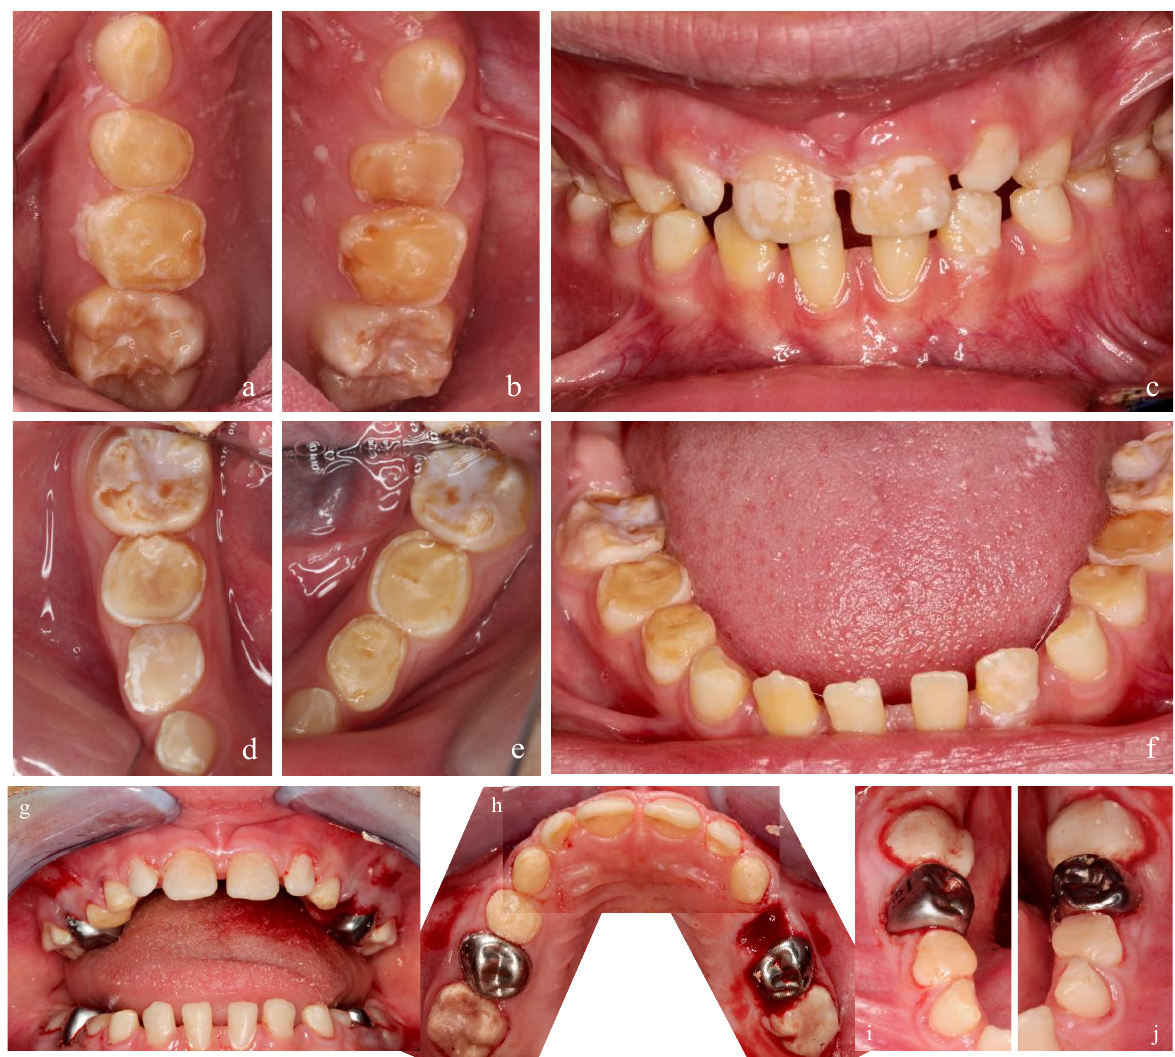
Figure 4. Plaster models of upper and lower jaws showing loss of tooth wear because of attrition and abrasion (physical tooth wear): ( a ) right side; ( b ) left side.